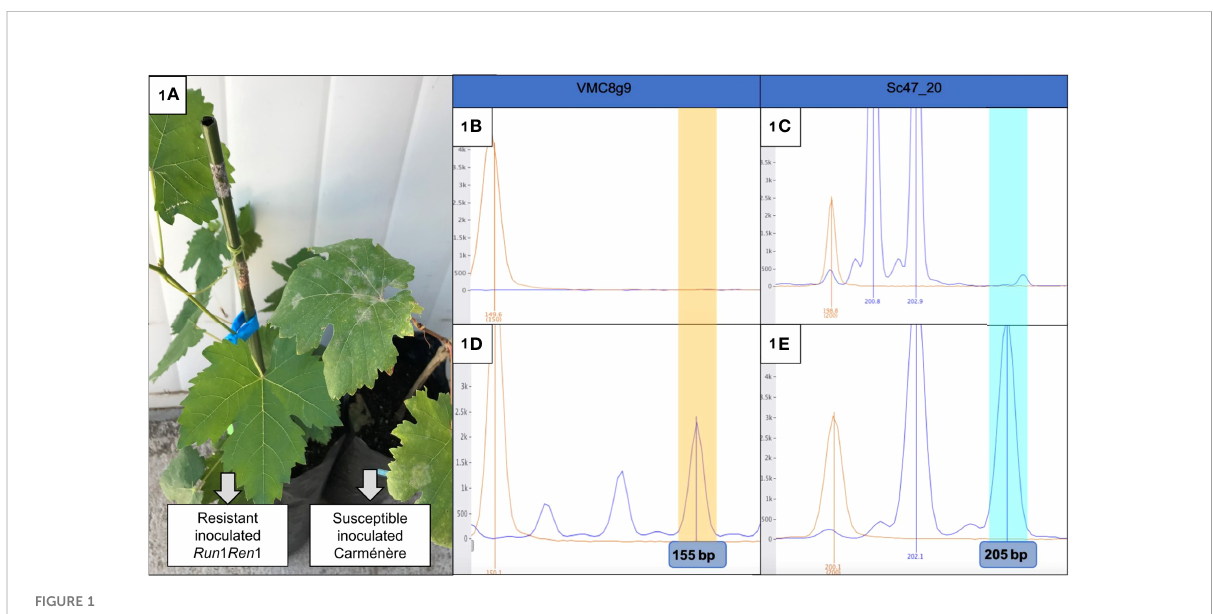
FIGURE 1 Phenotypic and genotypic analysis of P09-105-59 and Carme ́ nère plants. (A) Photo of the resistant Run1Ren1 P09-105-59 (left) and a susceptible Carme ́ n ́ ère (right) inoculated plants. The fi rst plant did not show any visible symptoms, unlike the second plant, that had a perceptible presence of fungus structures (white/grey dust); (B – E) Electrophoretogram of SSR analysis of resistant and susceptible Carme ́ n ́ ère plants. VMC8g is linked to Run1 and Sc47_20 is linked to Ren1 . P09-105-59 resistant genotype carried Run1 (D) and Ren1 (E) , on the other hand, Carme ́ n ́ ère did not have any of them (B, C) . Polymorphic fragments for VMC8g9 (155 bp) and Sc47_20 SSR (205 bp) are highlighted in yellow and blue,